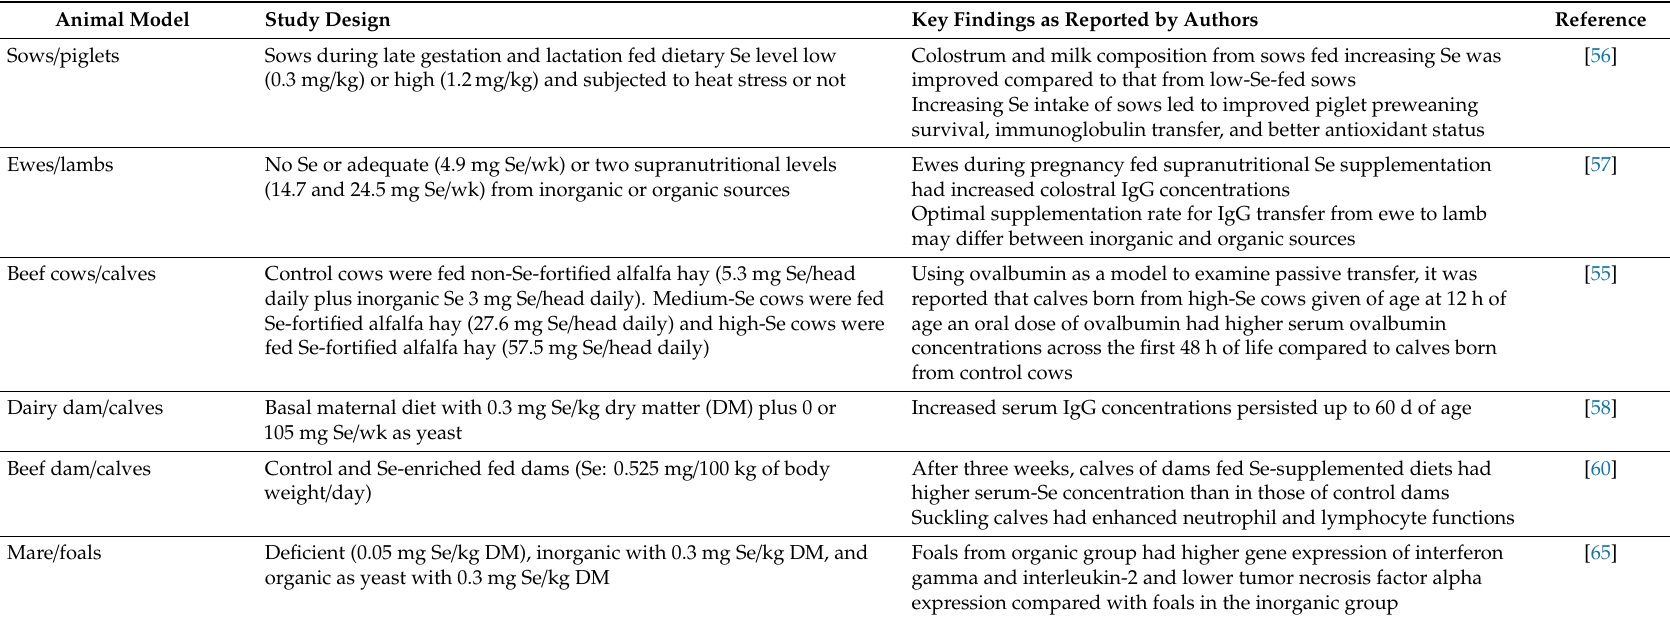
Table 2. A summary of selected animal studies reporting e ff ects of maternal Se status on immunity of the o ff